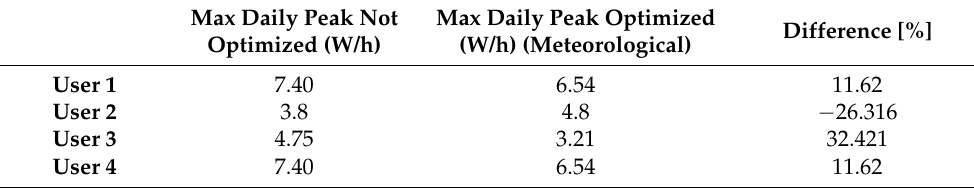
Table 4. Peak comparison between optimized and not optimized scheduling (statistical